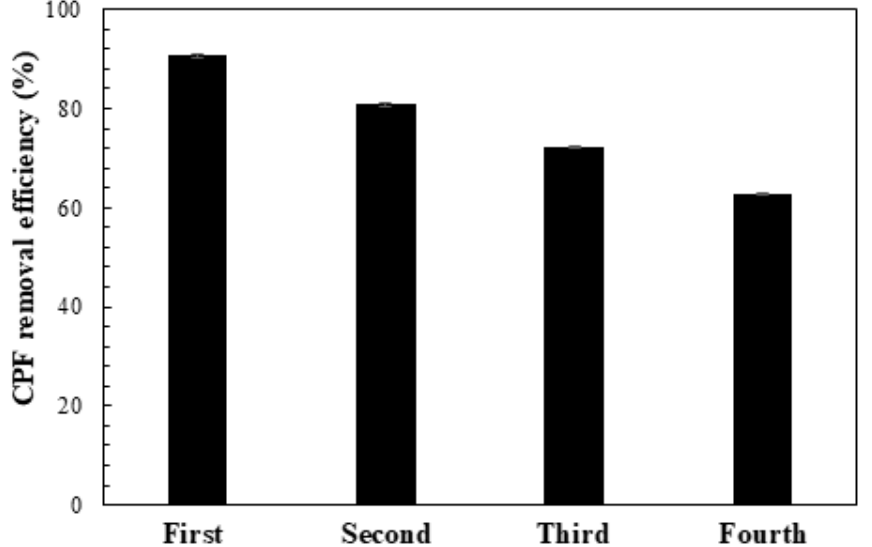
Figure 15. Efficiency of the Fe III -CS-GLA catalyst during repeated use for solar light-assisted oxida-tive degradation of CPF in aqueous solution. Experimental conditions: [CPF] 0 : 50 µM; [Fe ӀӀӀ ] 0 in Fe III - CS-GLA: 1.25 mM; [GLA] 0 in Fe III -CS-GLA: 90 mM; [H 2 O 2 ] 0 : 6 mM; volume of CPF solution: 250 mL; pH: 3, light intensity: 70,000–90,000 Lux; solar light irradiation time: 180 min.